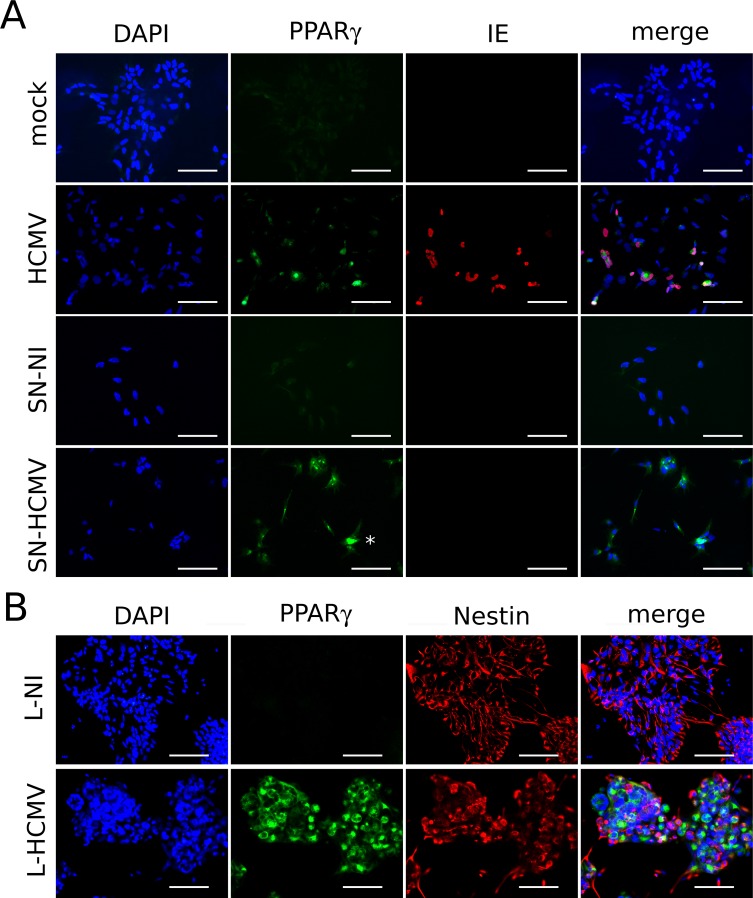
Soluble mediators from infected NSCs trigger the expression of PPARγ in uninfected NSCs.(A) Immunofluorescence analysis using antibodies specific to IE or PPARγ showing strong increase in PPARγ levels in NSCs infected by HCMV (HCMV), or in uninfected NSCs treated with supernatants prepared from HCMV-infected NSC cultures (SN-HCMV), as compared to uninfected NSCs treated with standard growth medium (mock), or NSCs treated with supernatants prepared from uninfected NSC cultures (SN-NI). The asterisk points to a representative cell with PPARγ nuclear staining. (B) Immunofluorescence analysis using antibodies specific to nestin or PPARγ showing strong increase in PPARγ levels in uninfected NSCs exposed to lipid extracts purified from the supernatants of HCMV-infected NSCs cultures (L-HCMV), as compared to NSCs exposed to lipid extracts purified from the supernatants of uninfected NSCs cultures (L-NI). Virus strain was AD169, and the MOI was 10 in all cases. Scale bar: 50 μm.